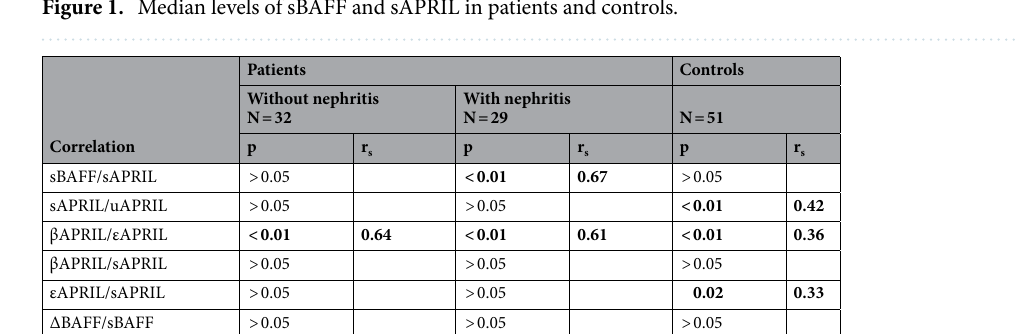
Figure 1. Median levels of sBAFF and sAPRIL in patients and controls.